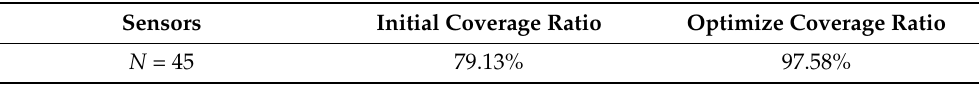
Figure 6. Coverage maps of sensors. ( a ) Initial coverage map of sensors; ( b ) Optimized coverage map of sensors. Table 8. Comparison of initial coverage and optimize coverage experimental results.